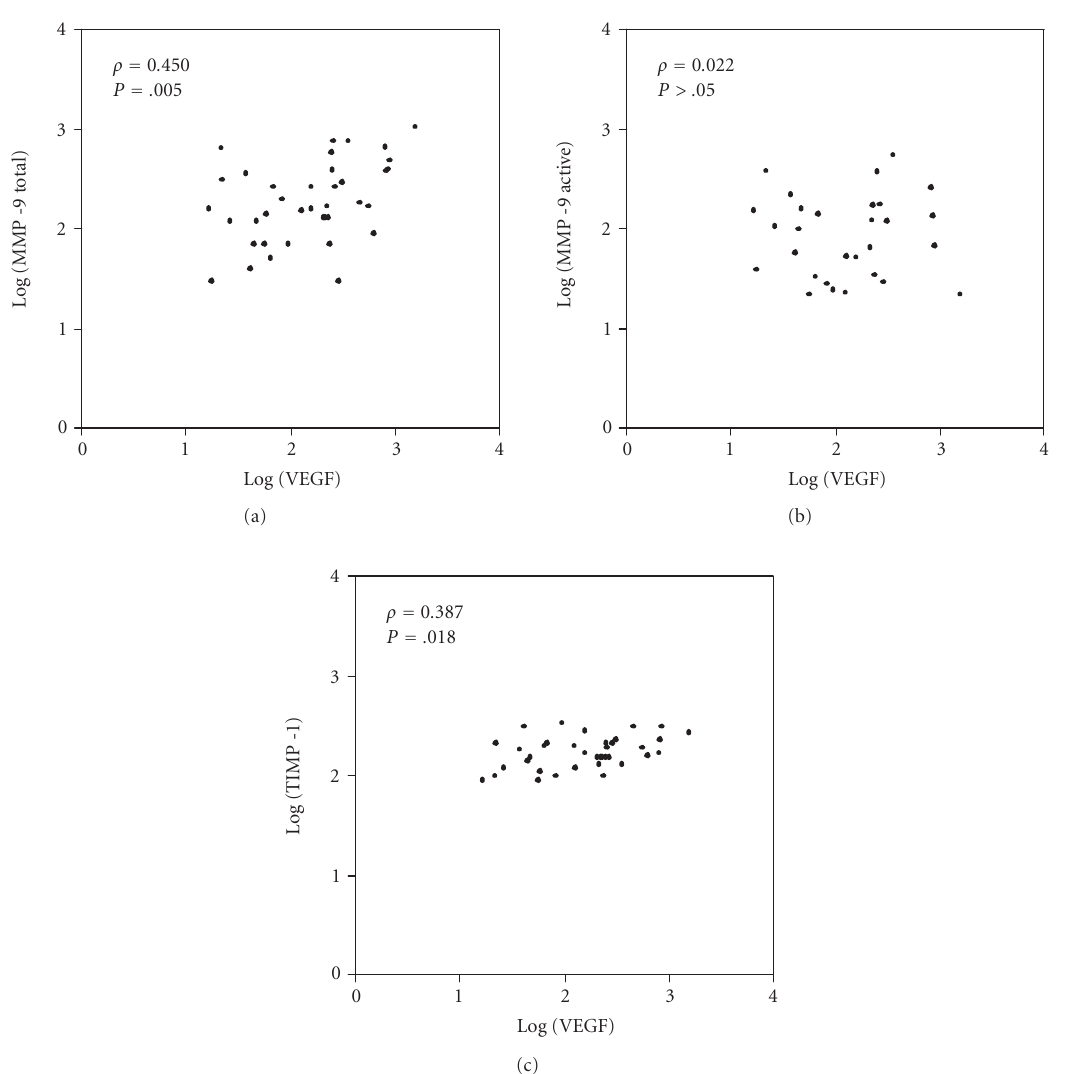
Figure 2: Correlations between VEGF and MMP-9 total, MMP-9 active, and TIMP-1 serum